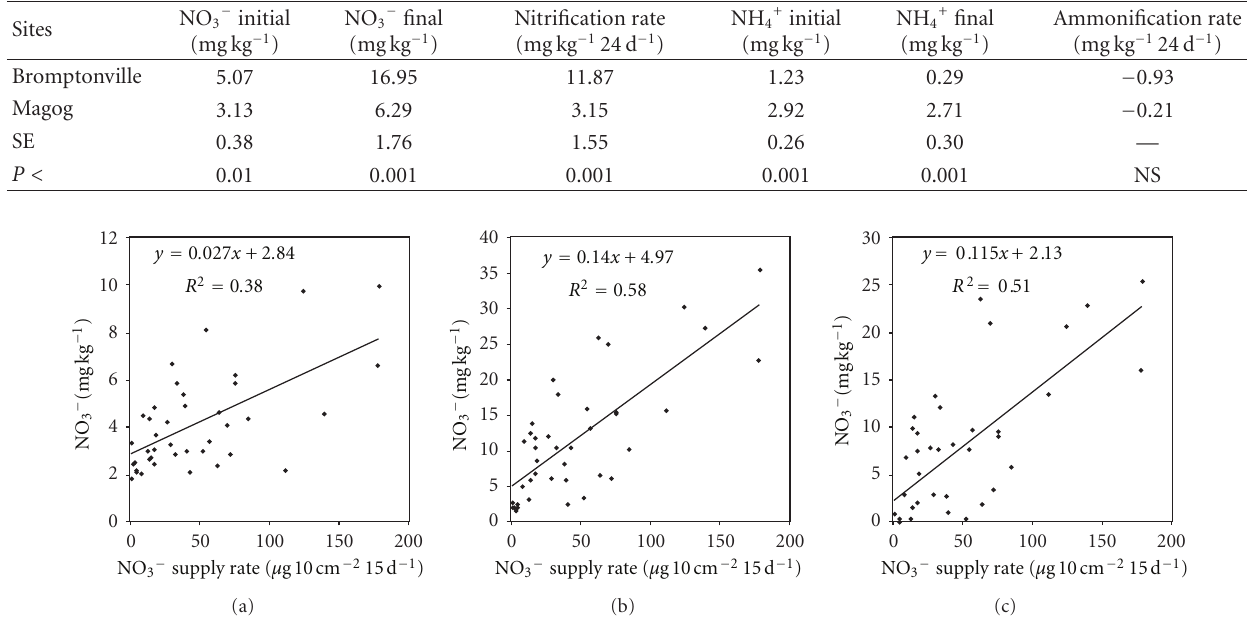
Figure 1: Linear relationships between soil NO 3 − supply rate and soil tube in situ incubations in riparian soils for 3 variables: (a) initial NO 3 − concentration in soil tube soils prior to incubation, (b) final NO 3 − concentration in soil tube soils following a 24 day incubation period, and (c) nitrification rate in soil tube soils during a 24 day incubation period. All relationships are significant at P < 0 .